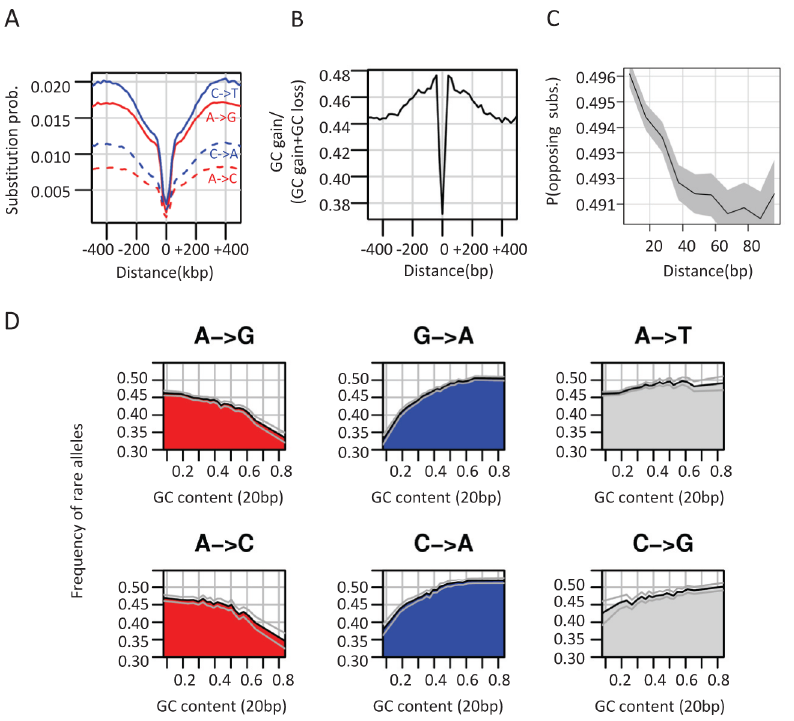
Figure 3. Non-neutral evolutionary dynamics around CEs. A) GC gain and GC loss rates around conserved elements. Shown are the average rates of different types of substitutions around CEs (see also Figure S3A). B) GC gain and loss balance. Plotted is the ratio of GC gain rate (combining all substitution types A/T R G/C) and total GC gain and loss rate at varying distance from CEs. C) Coupling between GC gain and loss. Using pairwise alignment of D. melanogaster and D. yakuba , we identified for each genomic distance (X axis) all pairs of loci within this distance that are both diverged between the two species. We then computed the fraction of such pairs that compensate an excess of GC in D. yakuba in one locus with an excess of GC in D. melanogaster in the other locus, out of all pairs of diverged loci. This non-parametric test shows that pairs of opposite GC changing substitutions are spatially more coupled as the distance between them decreases. Gray polygon represents binomial 95% confidence interval. For a parametric version of this test see Figure S3B. D) Frequency of rare alleles is correlated with GC content on a scale of 20 bp. We grouped SNPs according to mutation type and plotted the average frequency of rare allele p(0.01 , minor allele frequency , 0.05) for different levels of local GC content (20 bp). Binomial 95% confidence intervals are depicted as gray curves. See Figure S3D for analysis that is stratified for larger scale (200 bp) GC content.